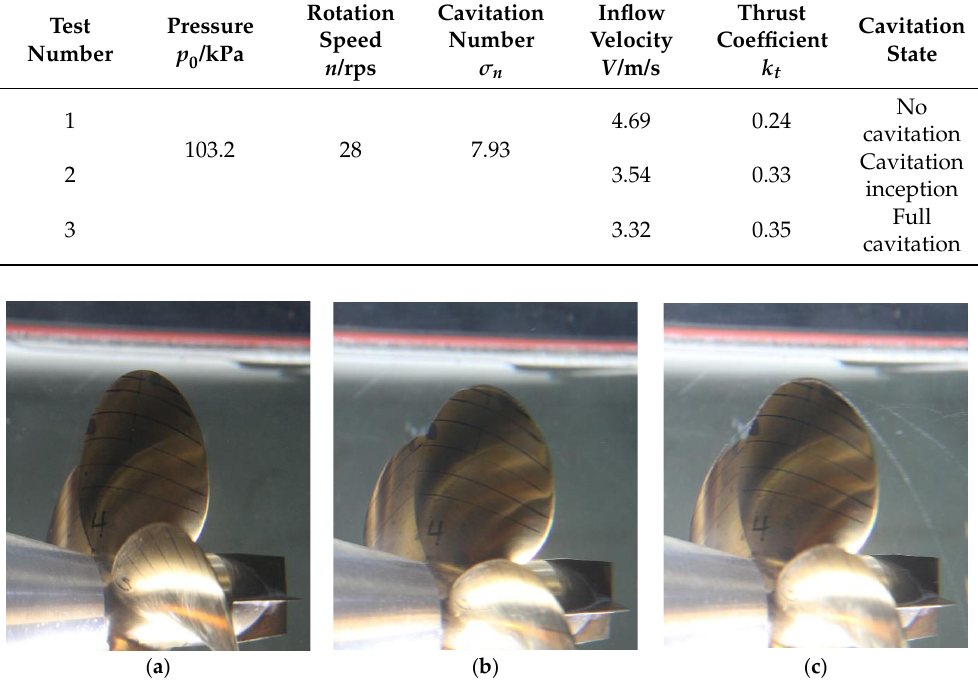
Figure 7. Images of propeller cavitation at three states: ( a ) no cavitation; ( b ) cavitation inception; ( c ) full cavitation. Table 4. Test condition and cavitation state of the propeller model.